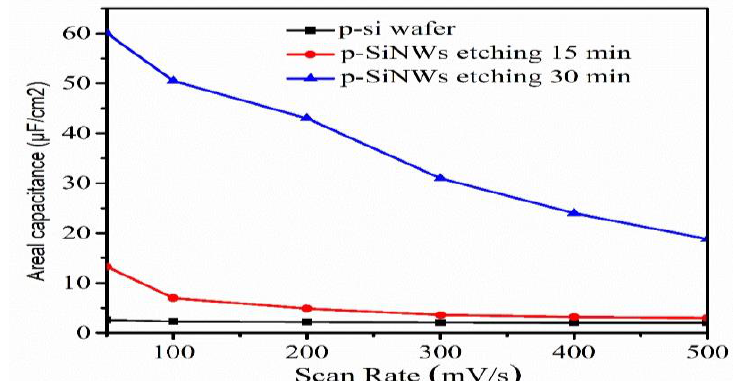
Figure 6: Areal capacitance of p-Si wafer, p- SiNWs etching 15 min, and p-SiNWs etching 30